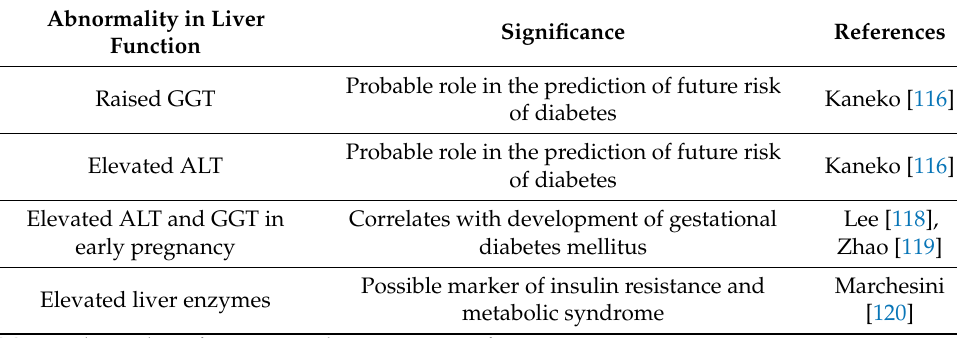
Table 3. Liver function biochemical markers as predictors of endocrine dysfunction.